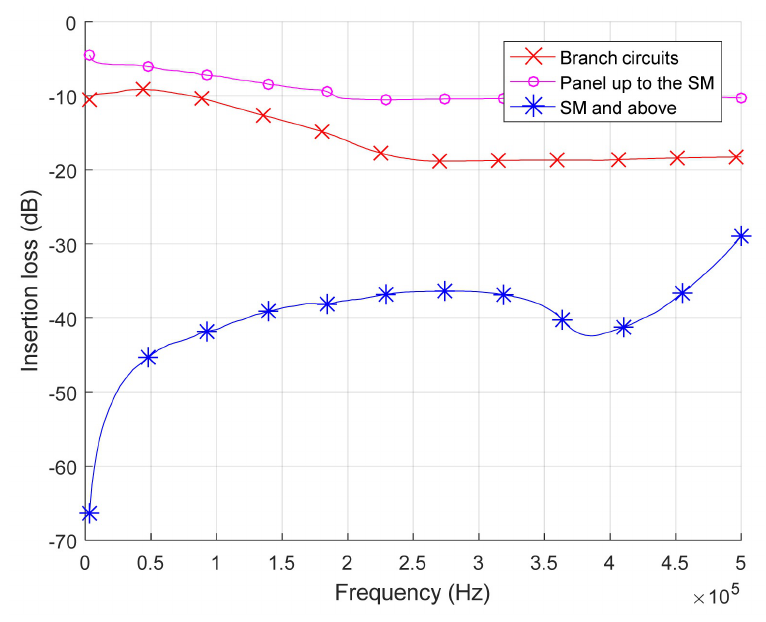
Figure 9. The average IL of the three parts of the home topology. Table 5. The IL of the Three Parts of the Home Topology.